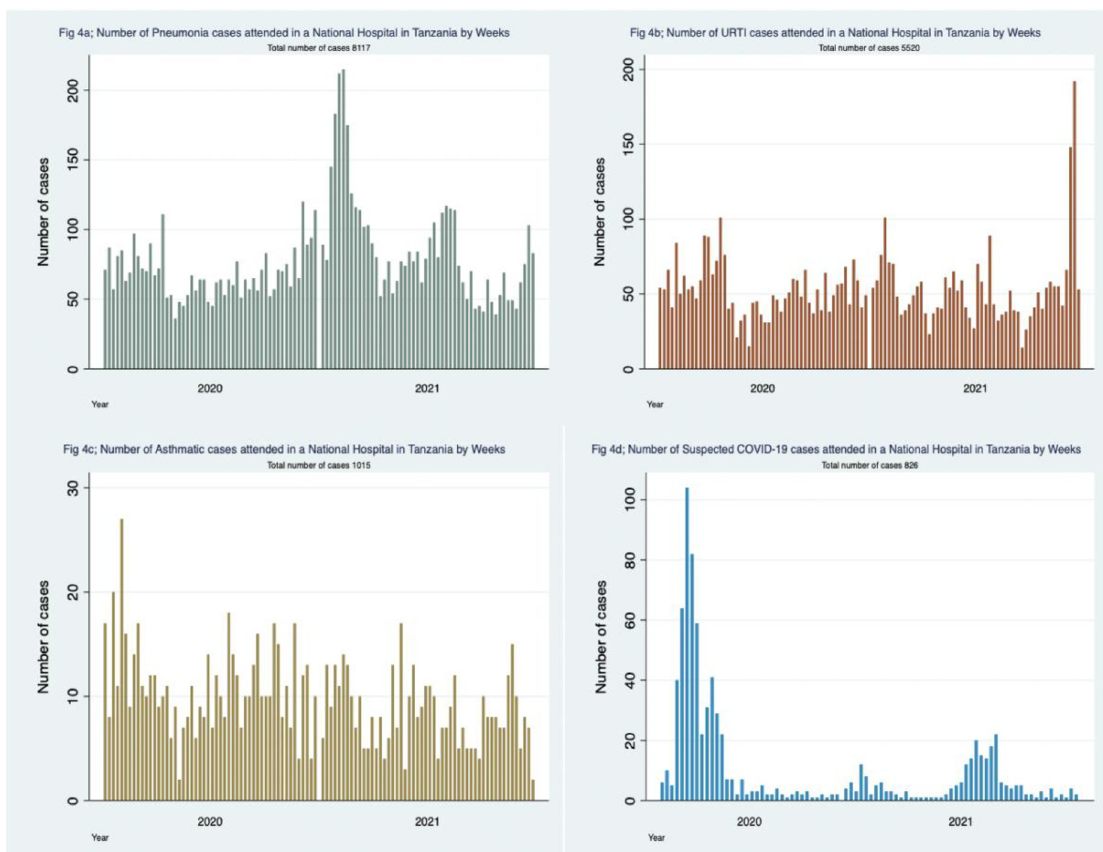
Fig 4. Common respiratory diagnoses presented in a Tanzanian National